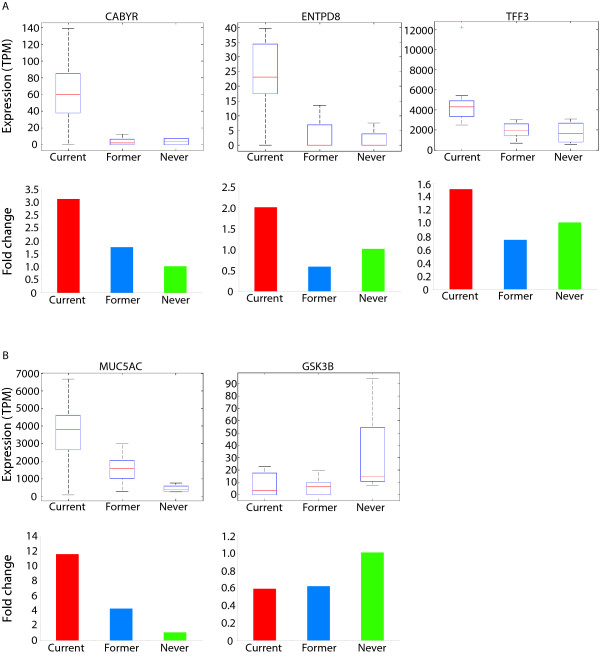
SAGE and quantitative PCR (qRT-PCR) analysis of select genes: (A) Genes found to have reversible expression upon smoking cessation. Box plots of SAGE data and histograms for qRT-PCR for CABYR, ENTPD8 and TFF3. Distribution of ratios between both current vs. former and current vs. former and never (Additional file IV) were found to be statistically different. (B) Genes found to be either partially or fully irreversible. Box plots of SAGE data and histograms for qRT-PCR for MUC5AC and GSK3B. Distribution of ratios between current vs. former and former vs. never were statistically different for MUC5AC and in addition, GSK3B was statistically significant for the combination of current and former vs. never. Box plot analysis was done using the Statistics toolbox from the MathWorks MatLab program. Red lines in the boxes represent the median expression value in terms of tags per million (TPM), and red "plus" signs represent outliers (values which are greater than 1.5 times the maximum value). The bottom and top part of the boxes represent the 2nd and 3rd quartiles of the data respectively. The error bars represent the 5th and 95th percentiles of the data. Quantitative RT-PCR validation was performed on a second cohort of nine current smokers, seven former smokers and six never smokers. Plotted is the average expression ratio relative to the average expression in never smokers of current (red), former (blue) and never (green) smokers. Statistical significance was determined using a one-tailed p-value from the Mann Whitney U Test (Supplemental Table IX).